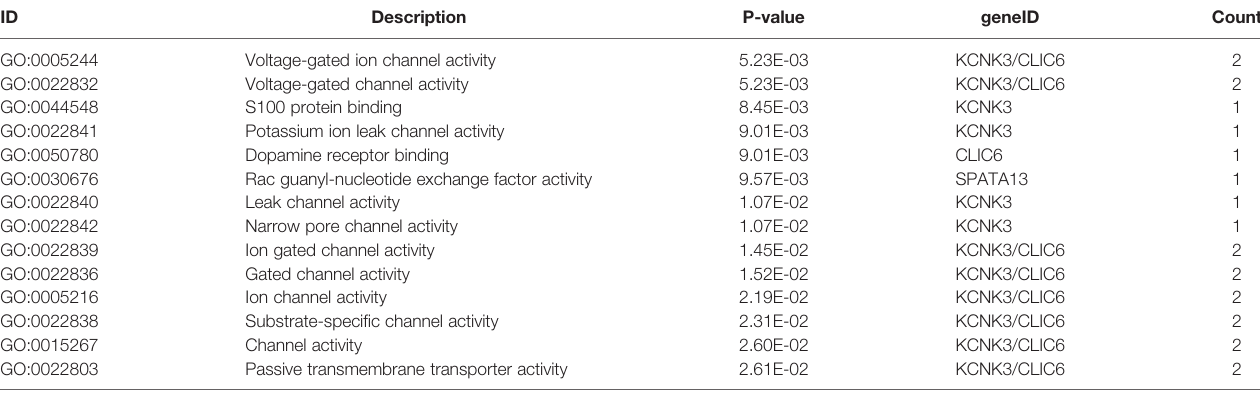
TABLE 2 | Signi fi cant biological processes in which the 11 gene signatures were mainly involved. ID Description P-value